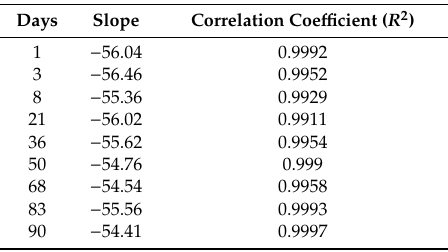
Table 2. Calibration result of Br-ISE in 90